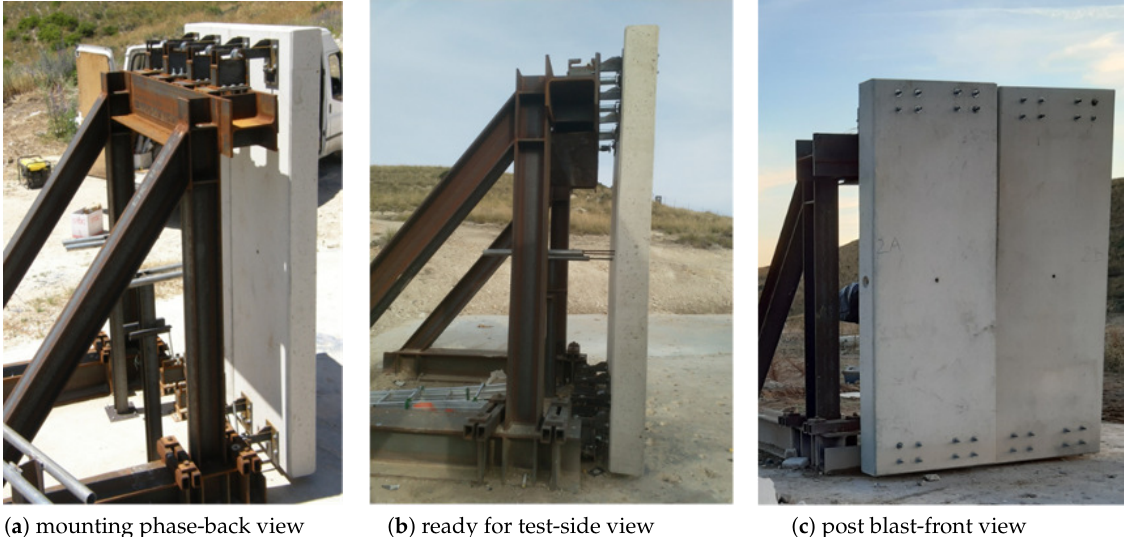
Figure 4. Views of the setup: two samples-rigid supports and EACs. Two reaction structures (setups 2 and 4 in Figure 2) placed face-to-face at 5 m from the explosive charge were used to carry out this research. Each of them supports two identical RC panels (2.75 × 1.00 × 0.21 m), which means that four panels with the same size and reinforcement pattern were tested simultaneously. One of the panels is connected to